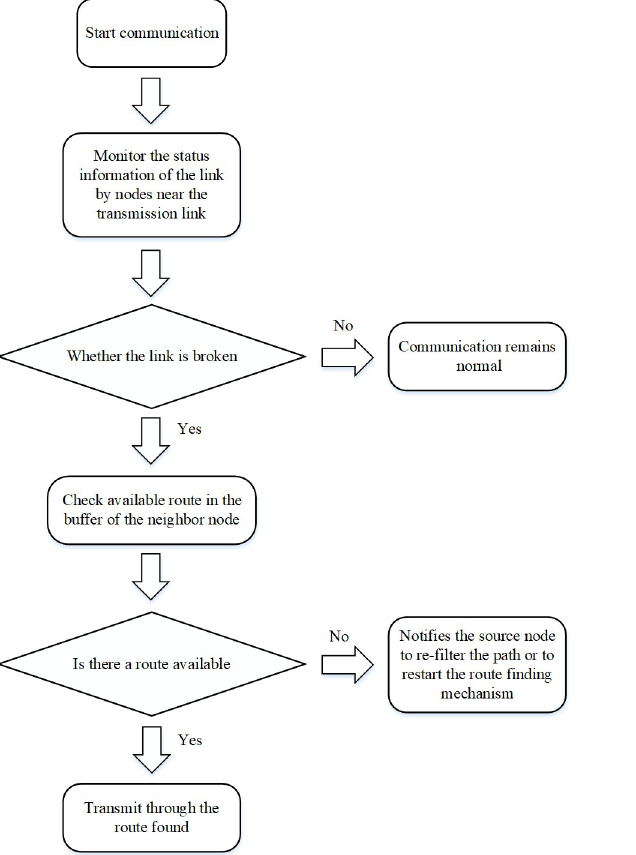
Fig 3. Flow chart of the monitoring repair